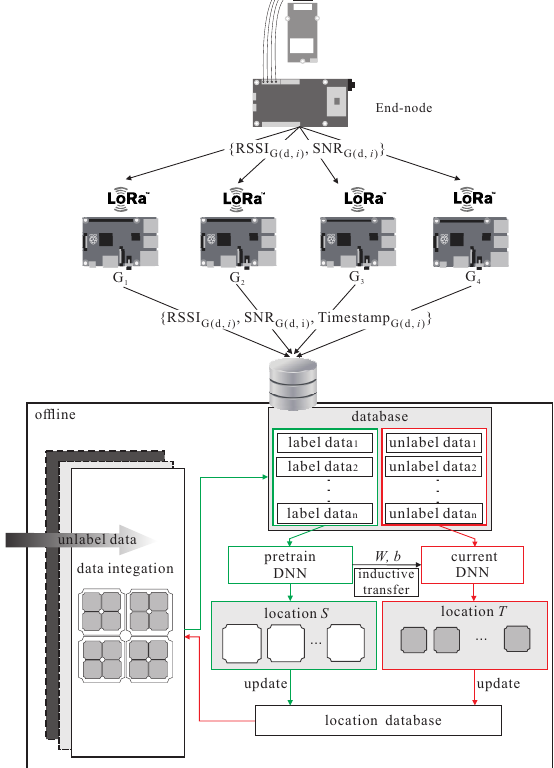
Figure 1. The LoRa localization system architecture using deep